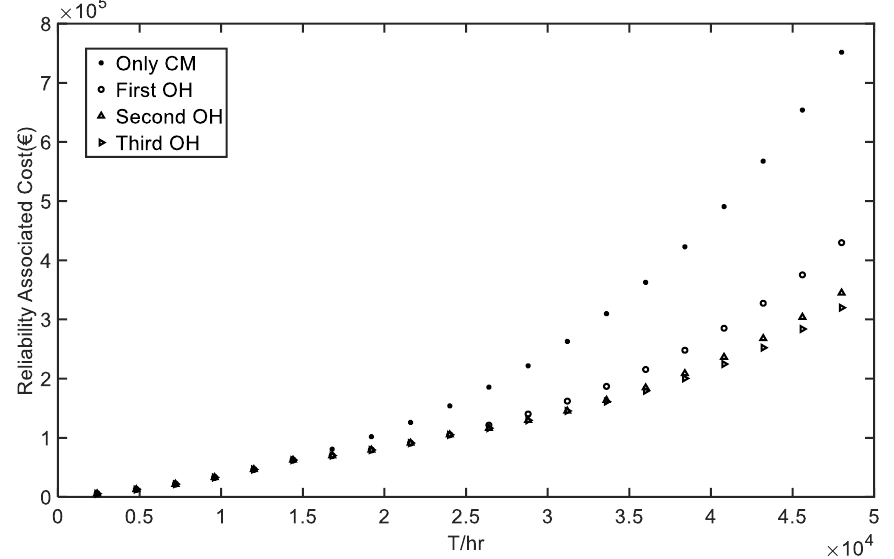
Figure 6. Comparative reliability associated cost between different maintenance